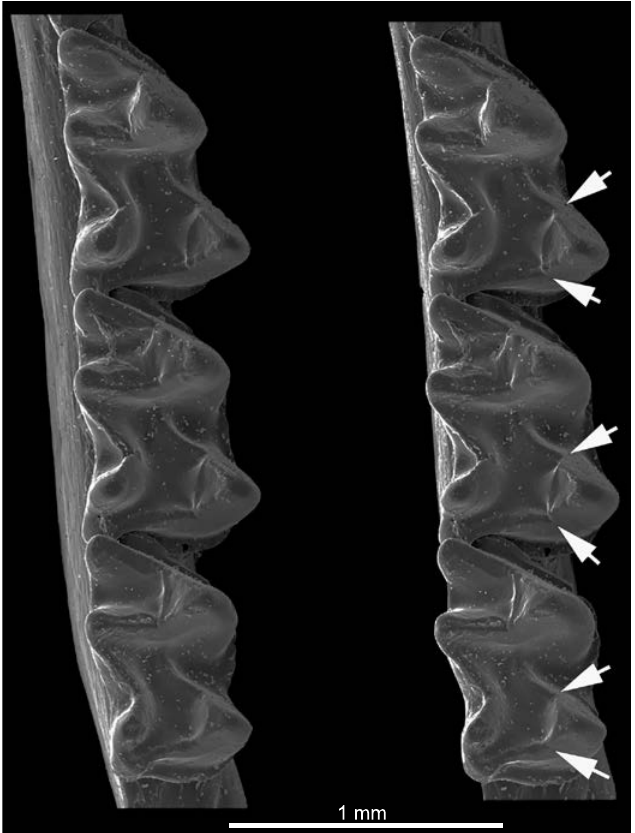
Fig. 4. Furipterid bat Furipterus horrens (Cuvier, 1828) (USNM 549505) from Brazil, Recent. Right lower molars in occlusal view (stereopair), showing angular entocristids and carnassiform notches (arrows) with ac- cessory troughs in the cristids obliqua and postcristids in